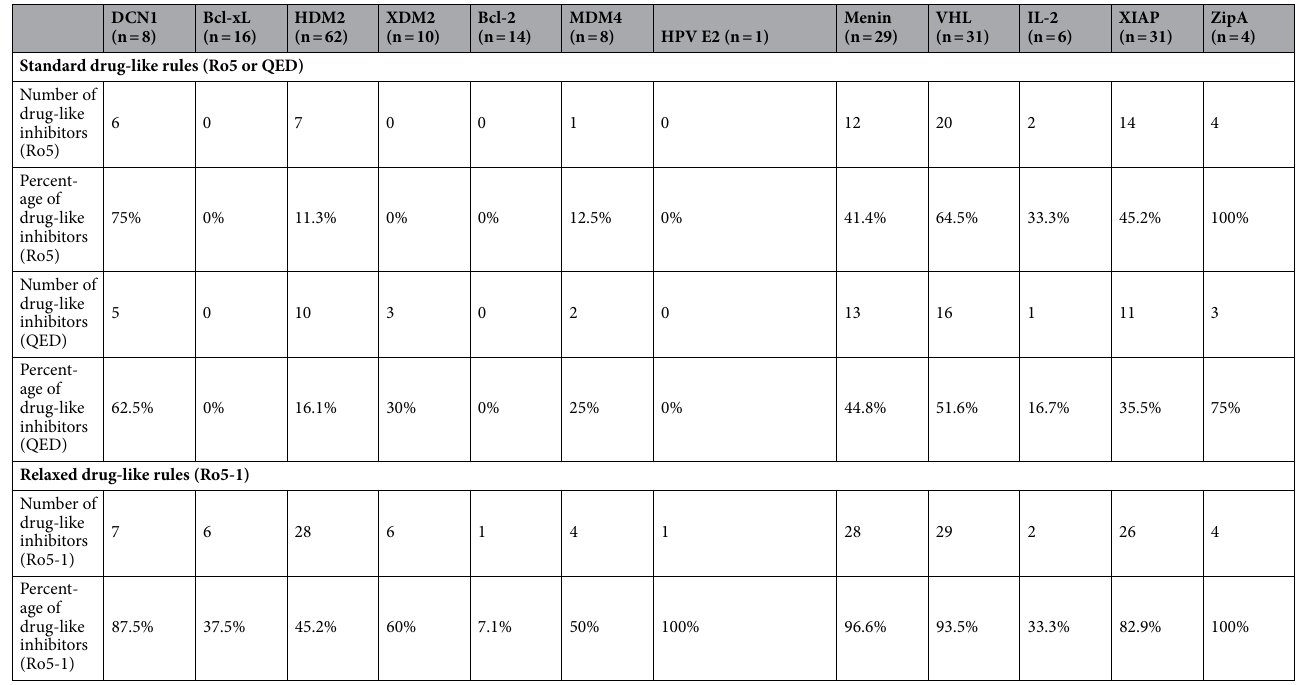
Table 4. Published PPI inhibitors classified as drug-like based on standard drug-like rules (Lipinski`s rule of 5 (Ro5) and QED scores); and relaxed PPI drug-like rules (Ro5-1).